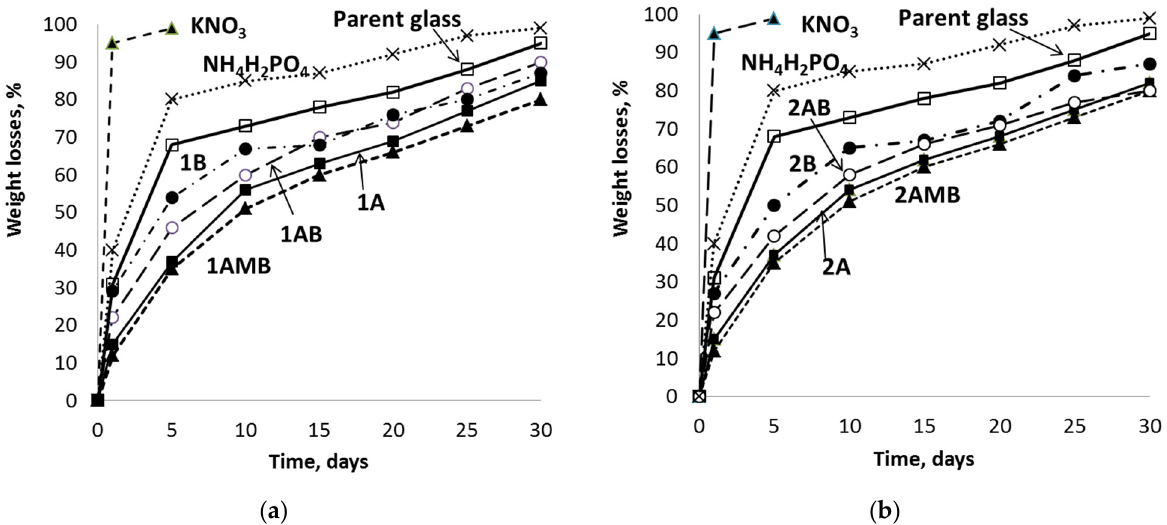
Figure 6. Kinetic curves of the dissolution of the prepared glass–matrix materials in water, in comparison with some traditional nitrogenous fertilizers. Materials based on the batches containing 4.2 wt.% ( a ) and 8.4 wt. % ( b ) of the Al, B, and Mg containing additives. The marks correspond to the numbers in Table 2.